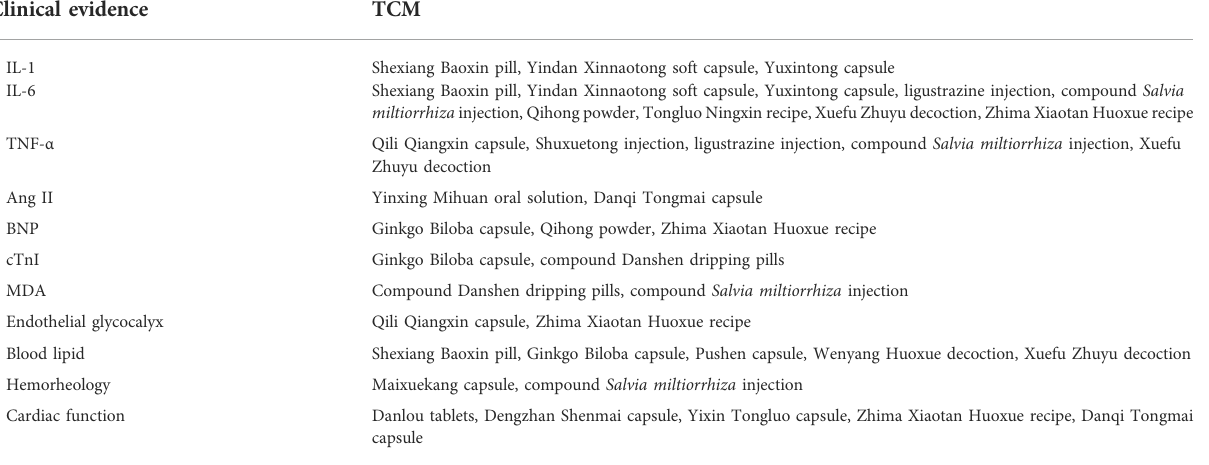
TABLE 2 ( Continued ) Clinical evidence of TCM for typical manifestations of